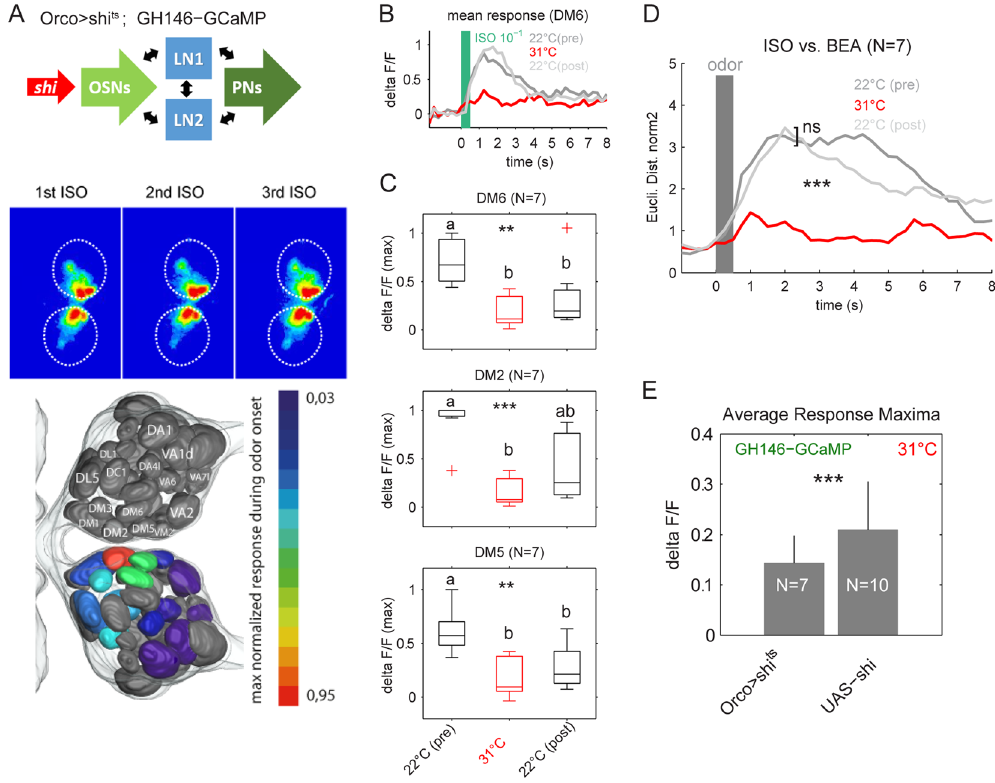
Figure 2. Silencing OSN output. ( A ) We silenced synaptic transmission of OSNs by expressing shi ts under the control of the Orco-promotor and monitored calcium signals via GCaMP3.0 in PNs using the GH146 enhancer trap line (see scheme part (i) in Fig. 1). False color coded pictures illustrate odor-evoked calcium responses of PNs during three repetitions of isoamylacetate (1 st –3 rd ISO) as it was performed in each experimental phase. We used the in vivo atlas 11 to identify the same set of 15 glomeruli in every animal (lower panel). ( B ) The responses to the three odor repetitions of each experimental phase were averaged for each glomerulus (DM6 is shown as an example). Phase 1: imaging at the permissive temperature (22 °C (pre), shi ts inactive, dark grey), phase 2: imaging at the non-permissive temperature (31 °C, silencing OSNs, red) and phase 3: imaging at the permissive temperature after 10 minutes (22 °C (post), shi ts inactive, light grey). Odor stimulation starts at time 0 and lasts for 500 ms (green bar). ( C ) Fluorescence maxima during application of ISO are shown for the three most responsive glomeruli for all three experimental phases (22 °C (pre) = black, 31 °C = red, 22 °C (post) = black) (N = 7). Comparing the experimental phases revealed a significant change in all three glomeruli (ANOVA, ** p < 0.01, *** p < 0.001). A pairwise post-hoc Wilcoxon rank sum test (p < 0.05) revealed significant decrease during 31 °C for all three glomeruli. Different letters indicate significant differences. ( D ) Euclidean distances were calculated between the time resolved population vectors of ISO and BEA in each experimental phase. Both odors could be equally well separated before and after silencing the OSNs (Wilcoxon rank sum test, n.s.), whereas odor separation is significantly decreased (collapsed) during the non-permissive temperature (Wilcoxon rank sum test, *** p < 0.001). ( E ) Averaged fluorescence maxima for both odors ISO and BEA pooled during the non-permissive temperature (31 °C) revealed a significant activity decrease compared to the parental control flies (Wilcoxon rank sum test, *** p <